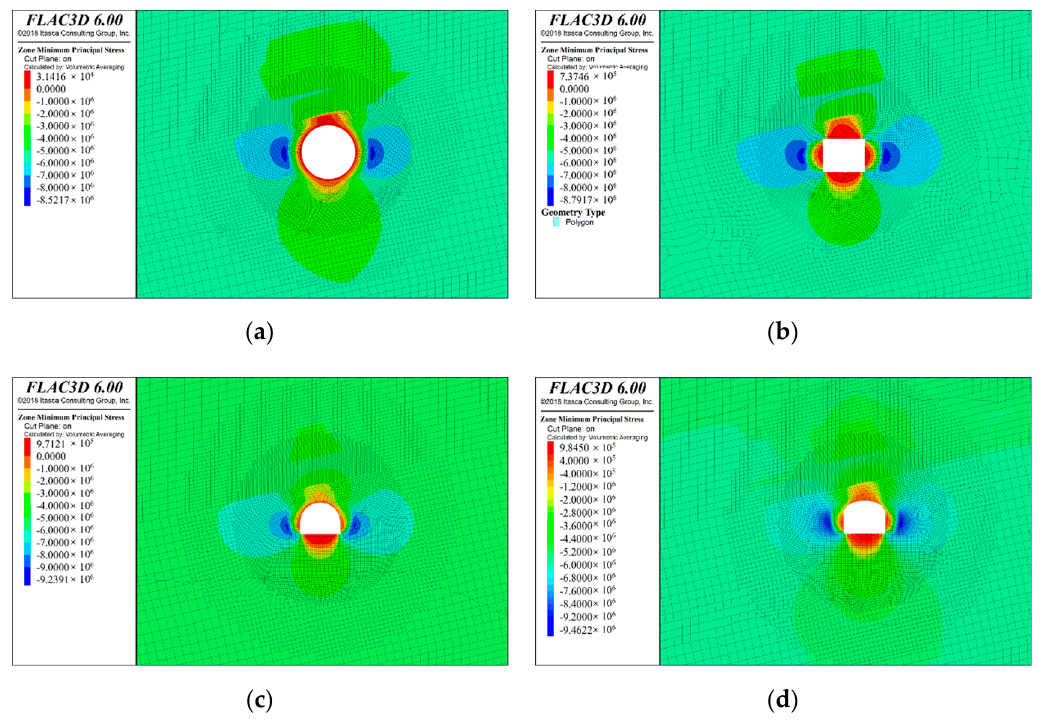
Figure 4. Influence of section shape on the cloud map of minimum principal stress distribution. ( a ) Circular section; ( b ) Rectangular section; ( c ) Semicircular arch section; ( d ) Three-center arch section.